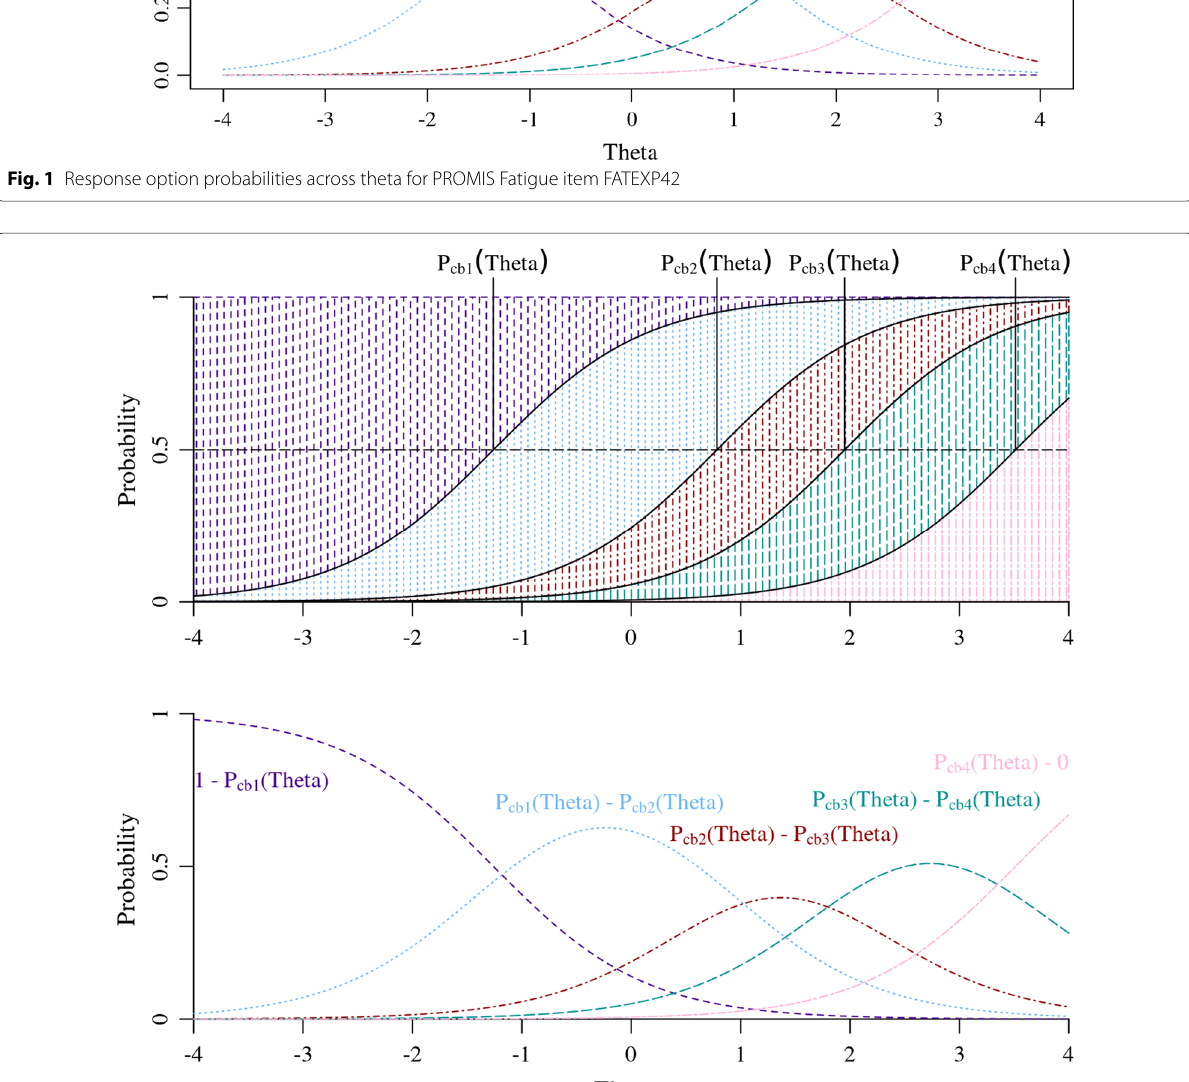
Fig. 2 Calculation of response option probabilities across theta using the graded response model calibrations from PROMIS Fatigue item